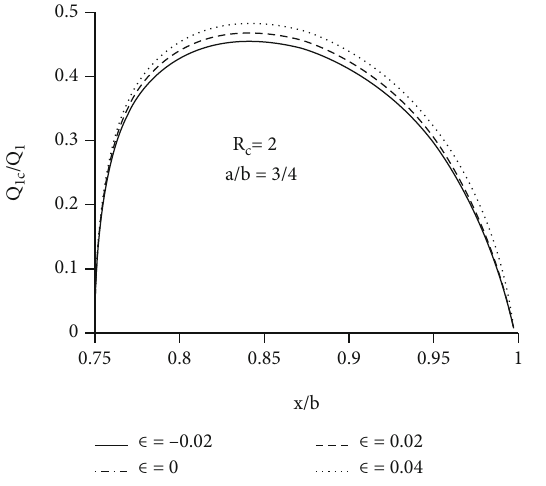
/ b with ε = − 0 : 02, 0, 0 : 02, 0 : 04 for R